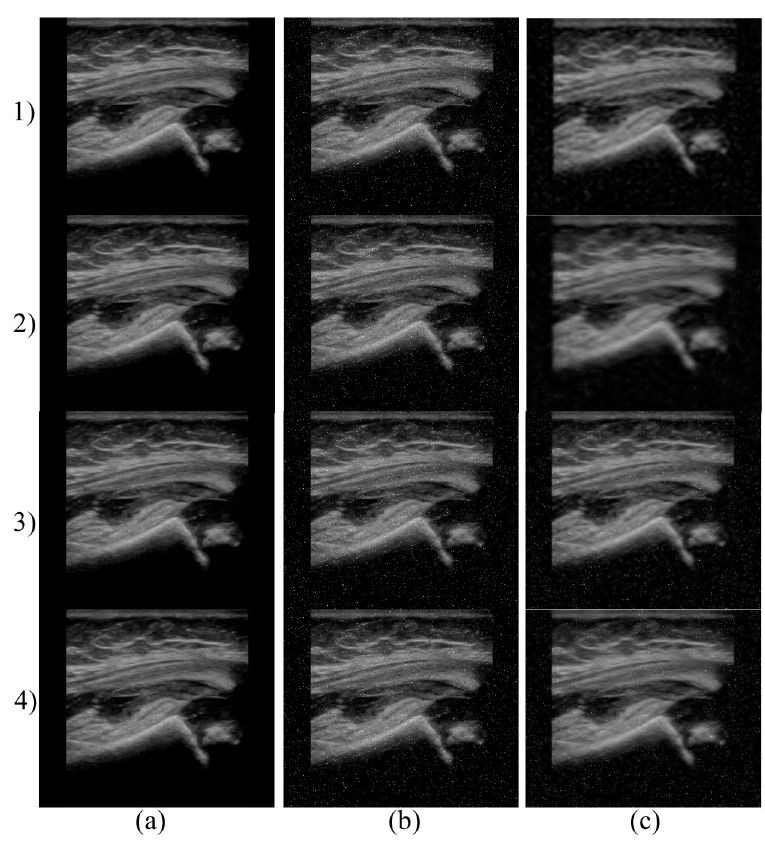
Fig 9. An example of denoising results on MSK image dataset using the selected wavelets. 1) Denoising using the Db25 , level of decomposition 3. a) native image, b) noisy image (Salt and Pepper noise ( d = 0.02)) and c) result of noise-canceling procedure; Denoising using the Db25 , level of decomposition 4. a) native image, b) noisy image (Salt and Pepper noise ( d = 0.02)) and c) filtration result; Denoising using the Sym29 , level of decomposition 3 (3) and Sym29 with level of decomposition 4 (4). a) native image, b) noisy image (Salt and Pepper noise ( d = 0.02)) and c) filtered MSK image.